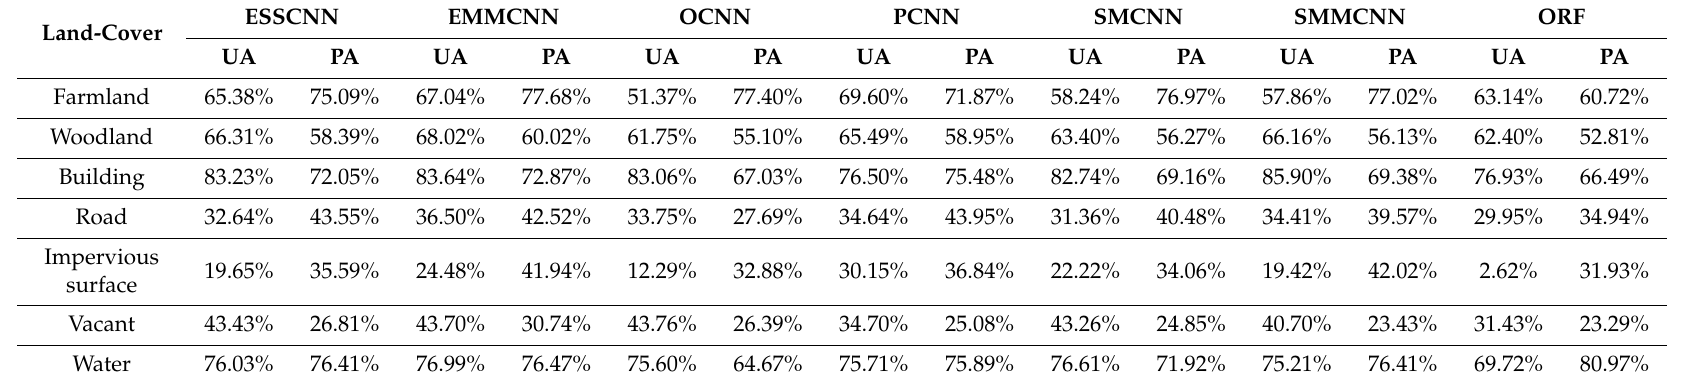
Table 11. Classification accuracy comparison amongst ESSCNN, EMMCNN, OCNN, PCNN, SMCNN, SMMCNN, and ORF methods for the Xiaoshan validating